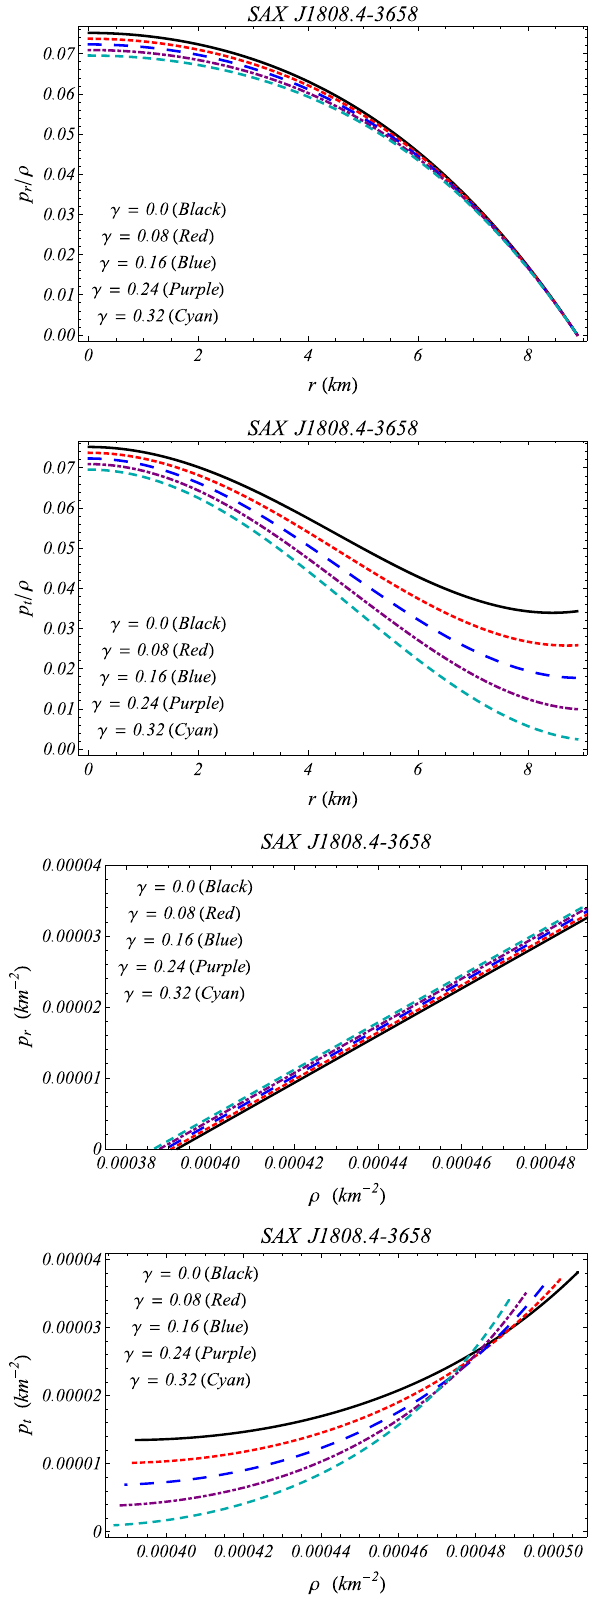
Fig. 7 The pressure density relation for different values of γ men- tioned in the